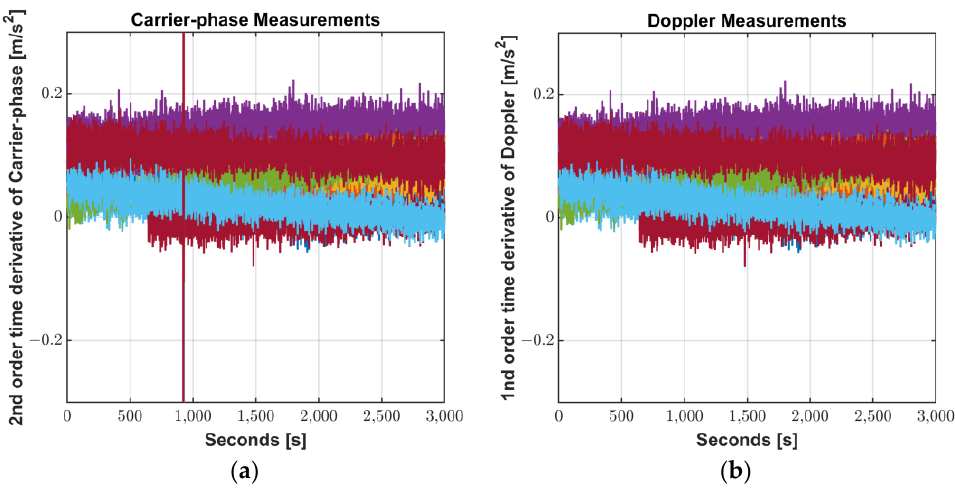
Figure 9. Noise level of measurements: ( a ) 2nd order time derivative of Carrier-phase; ( b ) 1st order time derivative of Doppler.